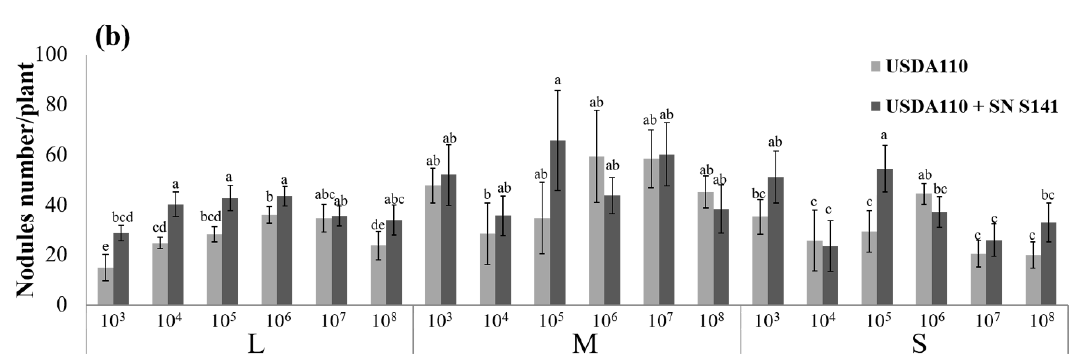
Figure 3. The nodule size separation of soybean cultivar Chiang Mai 60 by single inoculation and co-inoculation of supernatant of S141 with various doses of USDA110 at 45 DAI: ( a ) photograph of soybean nodule size separation of single inoculation and co-inoculation of supernatant of S141 with various doses of USDA110; and ( b ) soybean nodule size separation of single inoculation and co-inoculation with supernatant of S141 with various doses of USDA110. The number at the x-axis symbolized the varied inoculation doses of USDA110 are 10 3 , 10 4 , 10 5 , 10 6 , 10 7 , and 10 8 CFU mL − 1 . Significance at p ≤ 0.05 is indicated by mean standard error bars (n = 5 ).